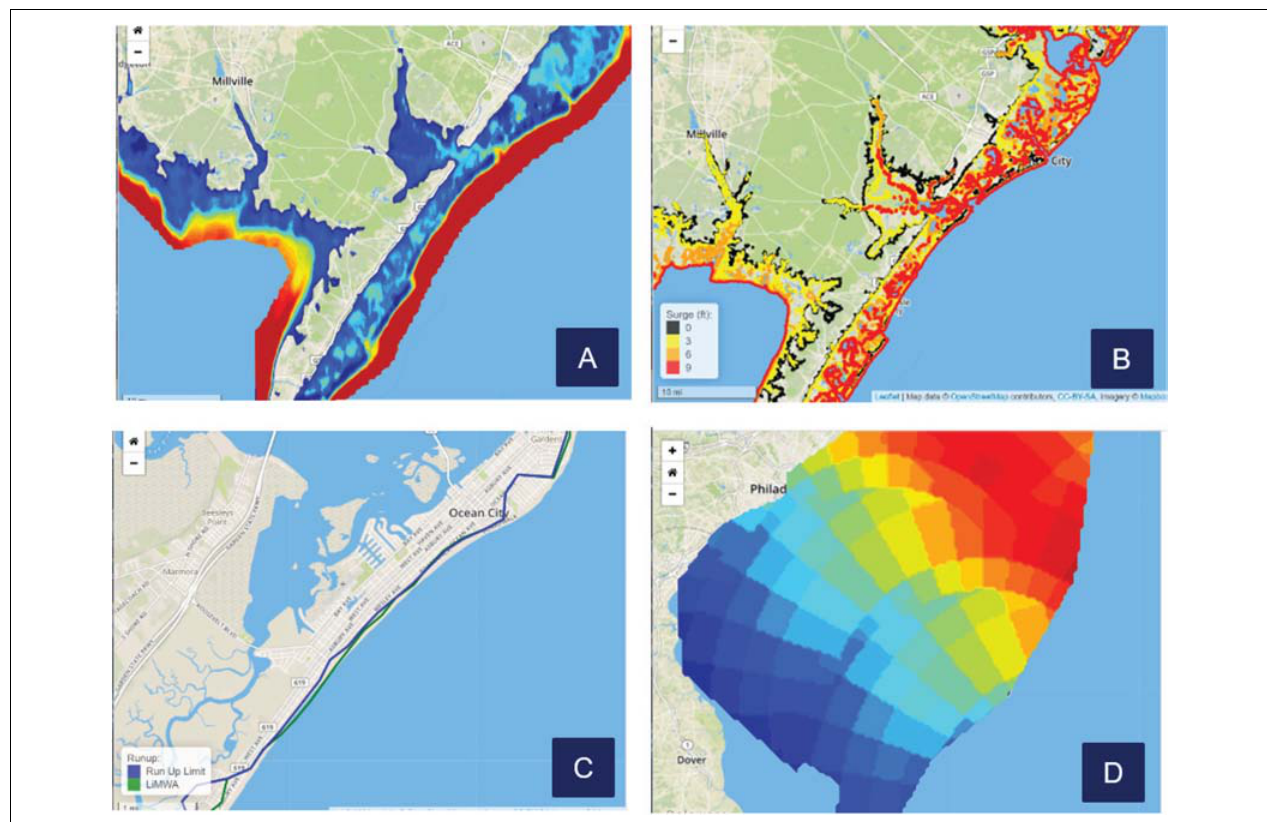
FIGURE 6 | NJcoast visualization options for SHP Tool outputs: (A) Storm surge heat map, (B) Storm surge contours, (C) Total run-up contours, and (D) Wind speed heat map.